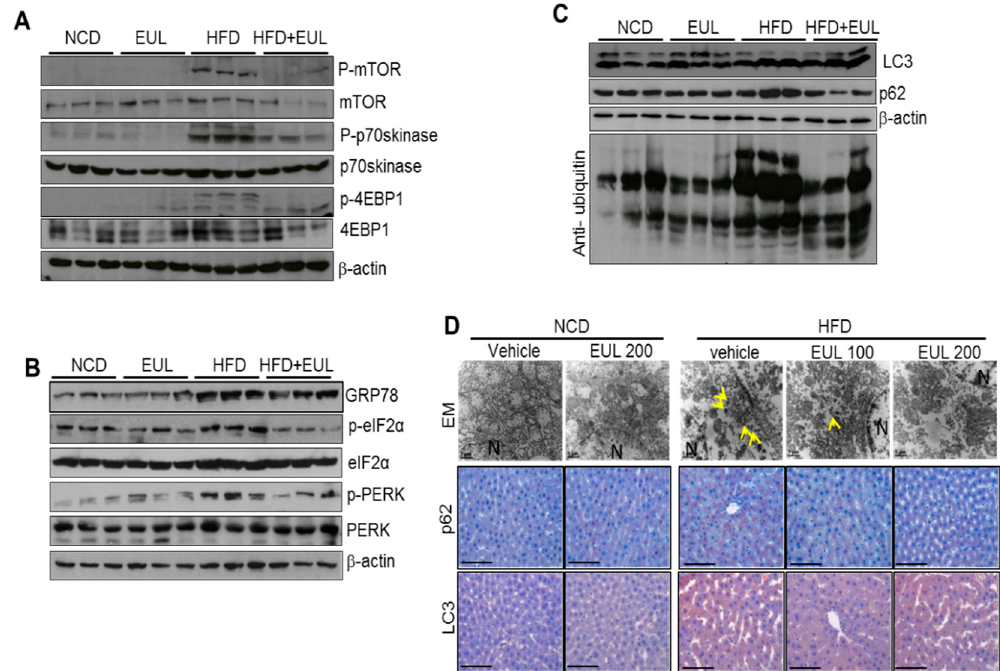
Figure 3. EUL inhibits ER stress in hyperlipidemic rats. ( A ) Experimental scheme. Rats were fed a HFD for 6 weeks, were given 100 mg/kg or 200 mg/kg EUL for 8 weeks, and were then sacrificed. Immunoblotting was performed using antibodies against p-mTOR, mTOR, p-p70S6K, p70S6K, p-4EBP-1, 4EBP-1, and β -actin. ( B ) Immunoblotting was performed using antibodies against GRP78, CHOP, p-PERK, PERK, p-eIF2 α , eIF2 α , and β -actin. ( C ) Immunoblotting was performed using antibodies against LC-3, p62, ubiquitin, and β -actin. ( D ) Representative EM images (upper panel) of anti-p62 immunostaining (middle panel), and anti-p62 immunostaining (lower panel). NCD, normal chow diet; HFD, high-fat diet; EUL, Eucommia ulmoides leaf extract; ER, endoplasmic reticulum.